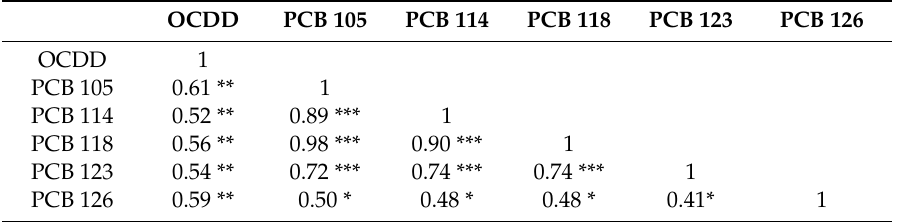
Table 2. Spearman’s correlation coe ffi cients among concentrations of PCDD / Fs and dl-PCBs. OCDD PCB 105 PCB 114 PCB 118 PCB